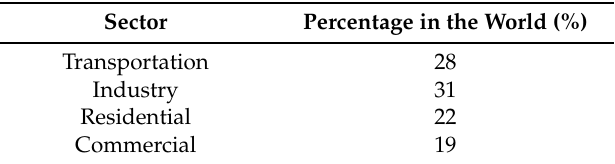
Table 1. Final energy consumers by sector in 2011. Source: